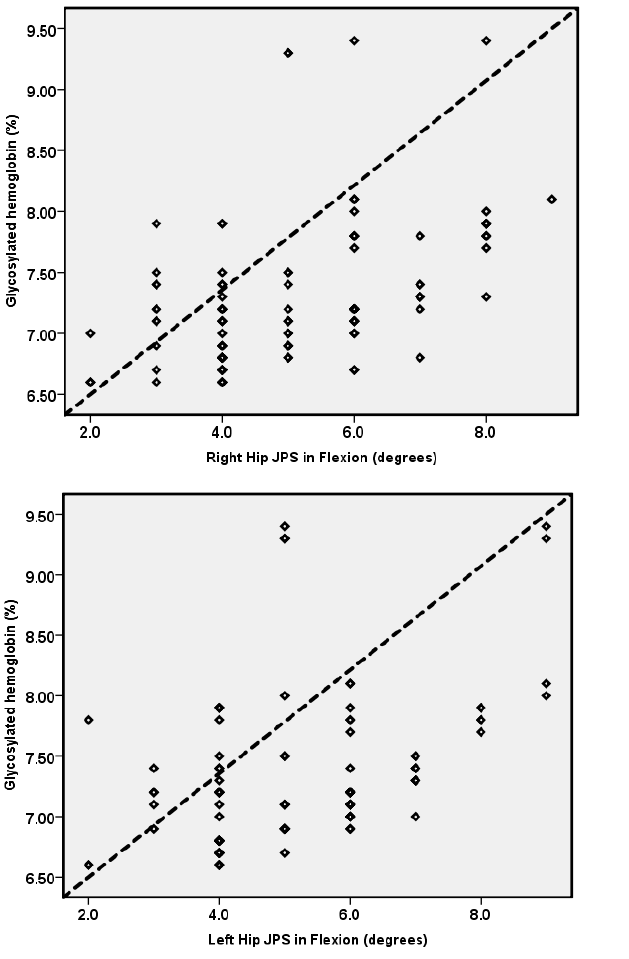
JPS = joint position sense, T2DM = type 2 diabetes mellitus, CI = confidence Interval, SEM = standard error of measurement, and MDC = minimal detectable change. p values are based on post-hoc Bon- ferroni correction. The magnitude of errors was significantly larger in the T2DM group in the right flexion ( p < 0.001), the right abduction ( p < 0.001), the left flexion ( p < 0.001), and the left abduction ( p < 0.001) directions compared to the asymptomatic group. The errors in the T2DM group were largest in left-hip abduction (5.48 ◦ ) and were least in right-hip flexion (5.10 ◦ ) directions. The position-sense errors in the asymptomatic group were highest in right-hip flexion (3.35 ◦ ) and were lowest in left-hip abduction (2.35 ◦ ) directions (Table 2). The SEM ranged from 0.64 to 0.68 degrees, and the MDC ranged from 1.76 to 1.87 (Table 2). The relationship between HbA1c and hip JPS is summarized as a scatterplot in Figure 3.